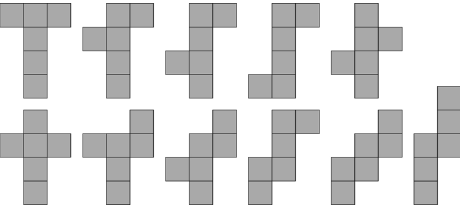
Fig. 8. Eleven nets of a